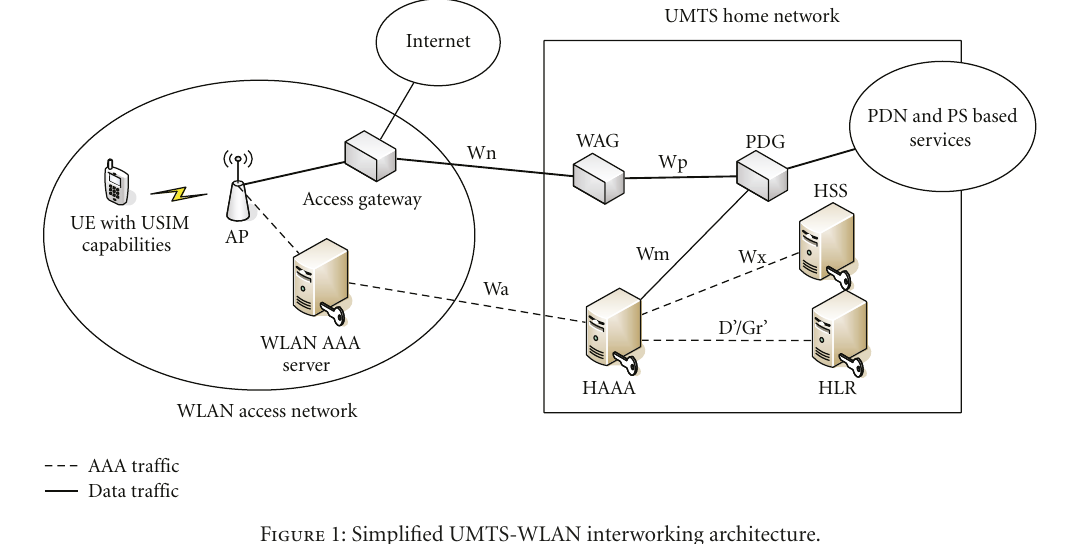
Figure 1: Simplified UMTS-WLAN interworking architecture.